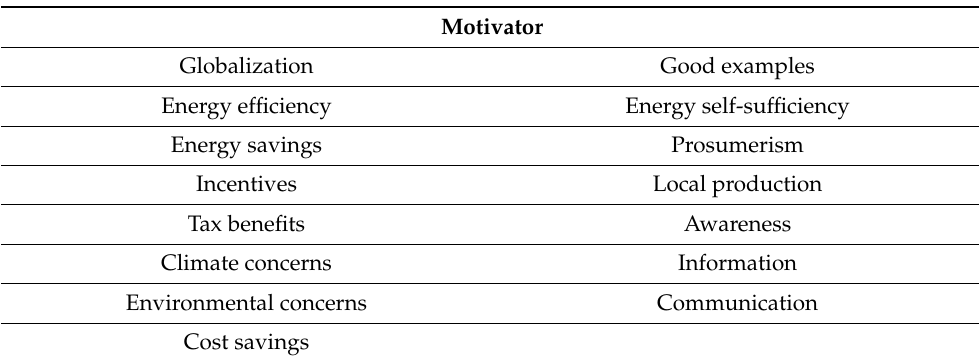
Table 2. Motivators for formal social units (source: Biresselioglu et al. [28]).